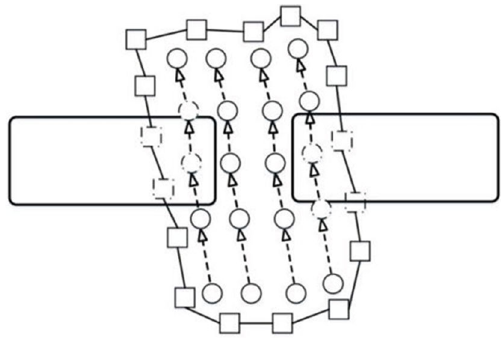
Figure 10: An enclosing shell of characters gets through